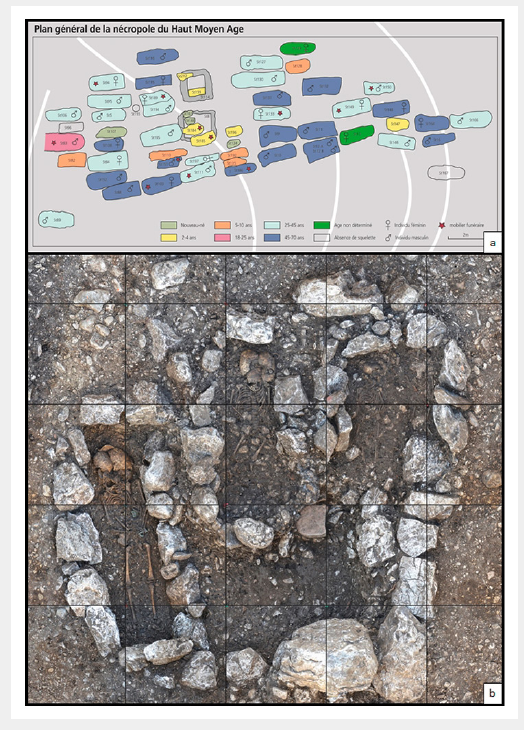
a: Plan of the early medieval cemetery in Courroux, Place des Mouleurs; b: several children were buried in the remains of two stone-lined Roman cellars in the middle of the cemetery.